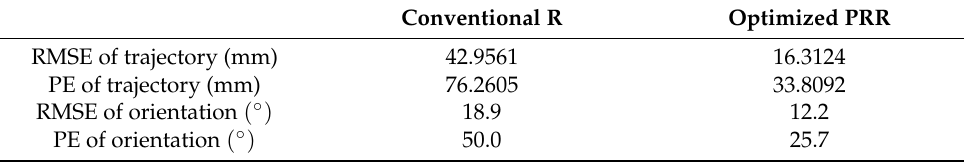
Figure 12. Actual trajectory tracking results of conventional R and optimized PRR configuration for six motions. Table 4. Actual trajectory and orientation error during additional work-related motions. Table 3. Actual trajectory and orientation error during optimized motions.